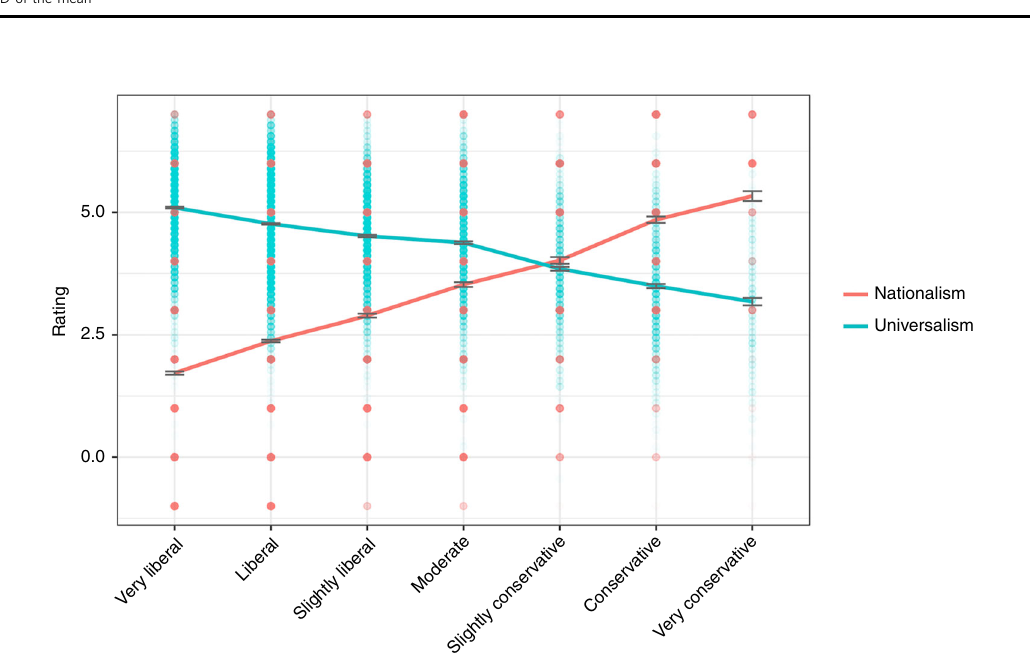
Fig. 2 Endorsement of values by political ideology, Study 1b. Error bars represent standard errors, solid lines indicate means. Source data are provided as a Source Data fi